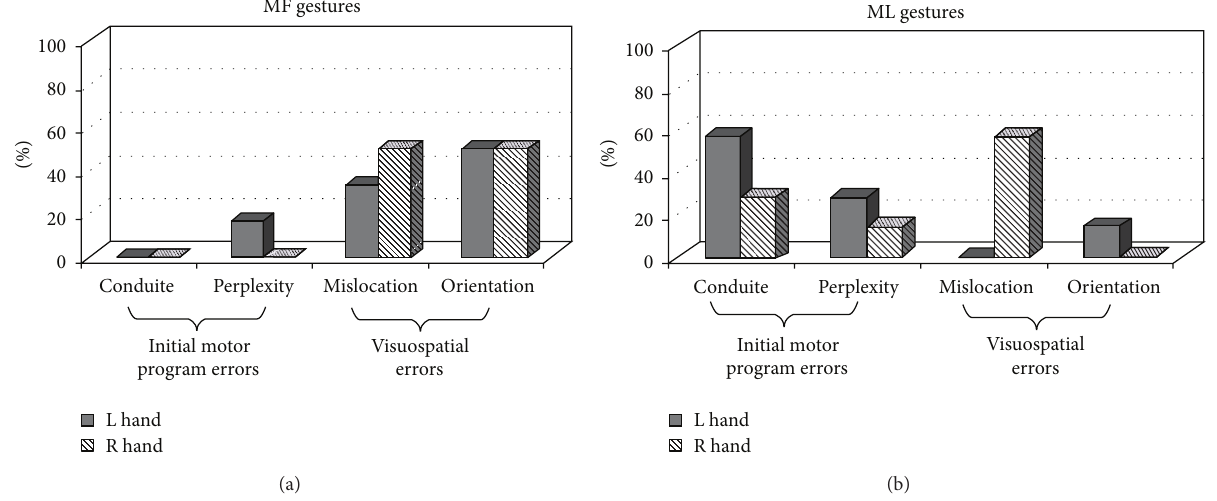
Figure 1: Error analysis of meaningful (MF) and meaningless (ML) gesture